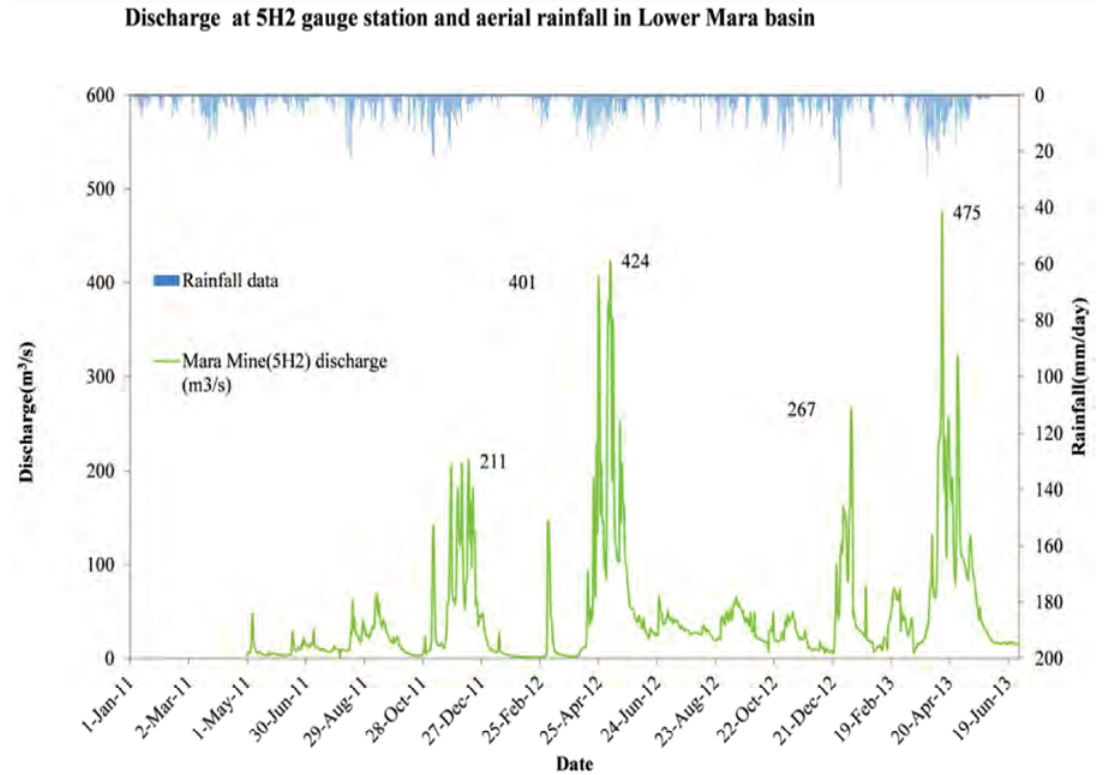
Figure 2. Discharge and areal rainfall at Mara mine gauging station. The values show four flood events during November/December and